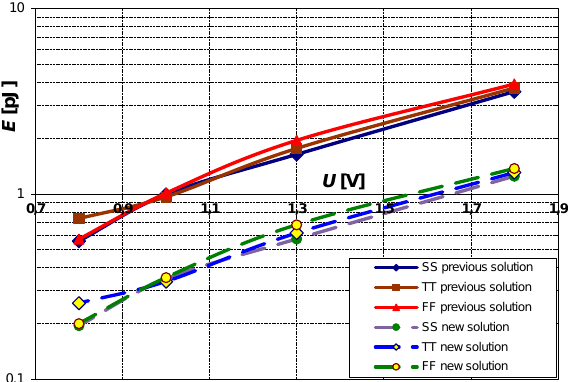
Figure 18. Energy consumption per a single neuron, for different supply voltages, 20 ◦ C, for three transistor